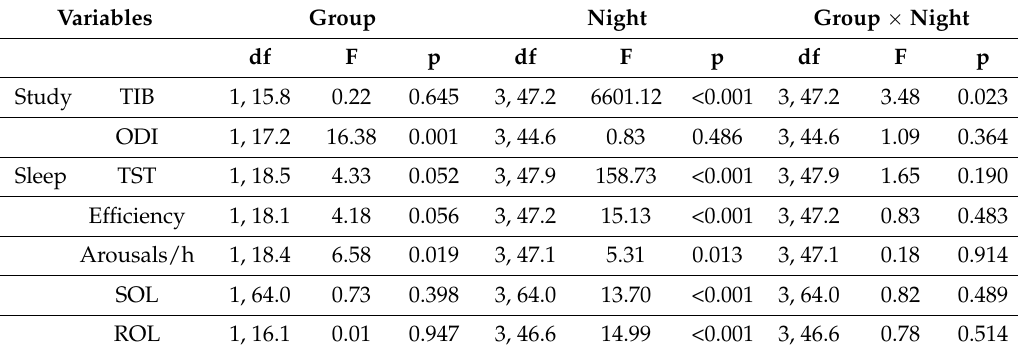
Table 1. Summary of mixed effects ANOVA results for sleep and study